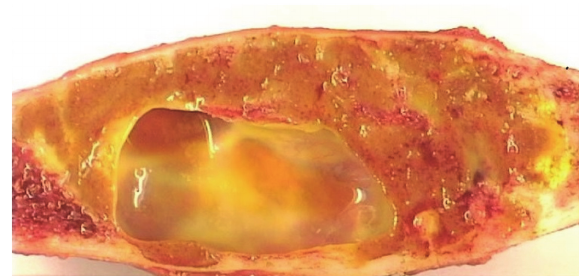
Figure 1: Giant cell tumor (GCT) in fibula with secondary aneurys- mal bone cyst. Treated with wide resection.